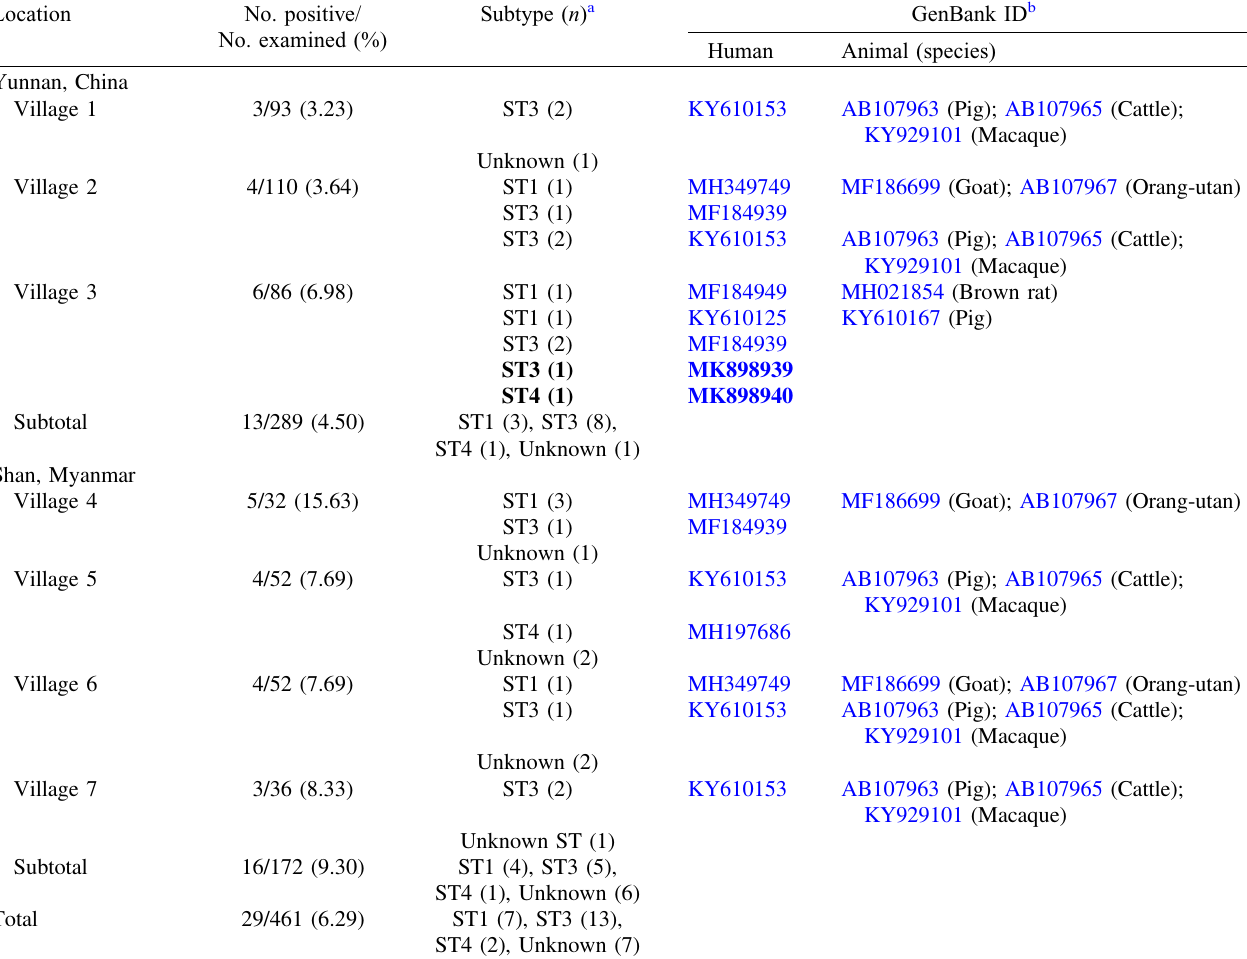
a Unknown indicates preparations in which DNA was only ampli fi ed and sequenced successfully in approximately 260 bp region of the SSU rRNA gene of Blastocystis . b Accession No. indicating the sequences downloaded from GenBank, which have 100% homology with the sequences obtained in the present study except two novel sequences (highlighted in bold) obtained